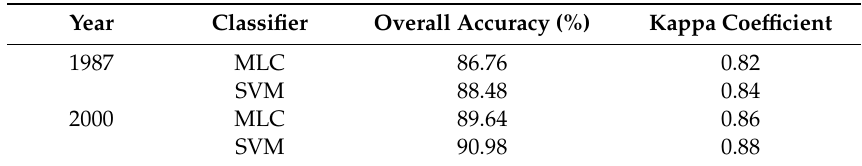
Table 7. Comparison between the Support Vector Machine (SVM) and Maximum Likelihood Classifier (MLC) for the classification of the 1987 and 2000 satellite